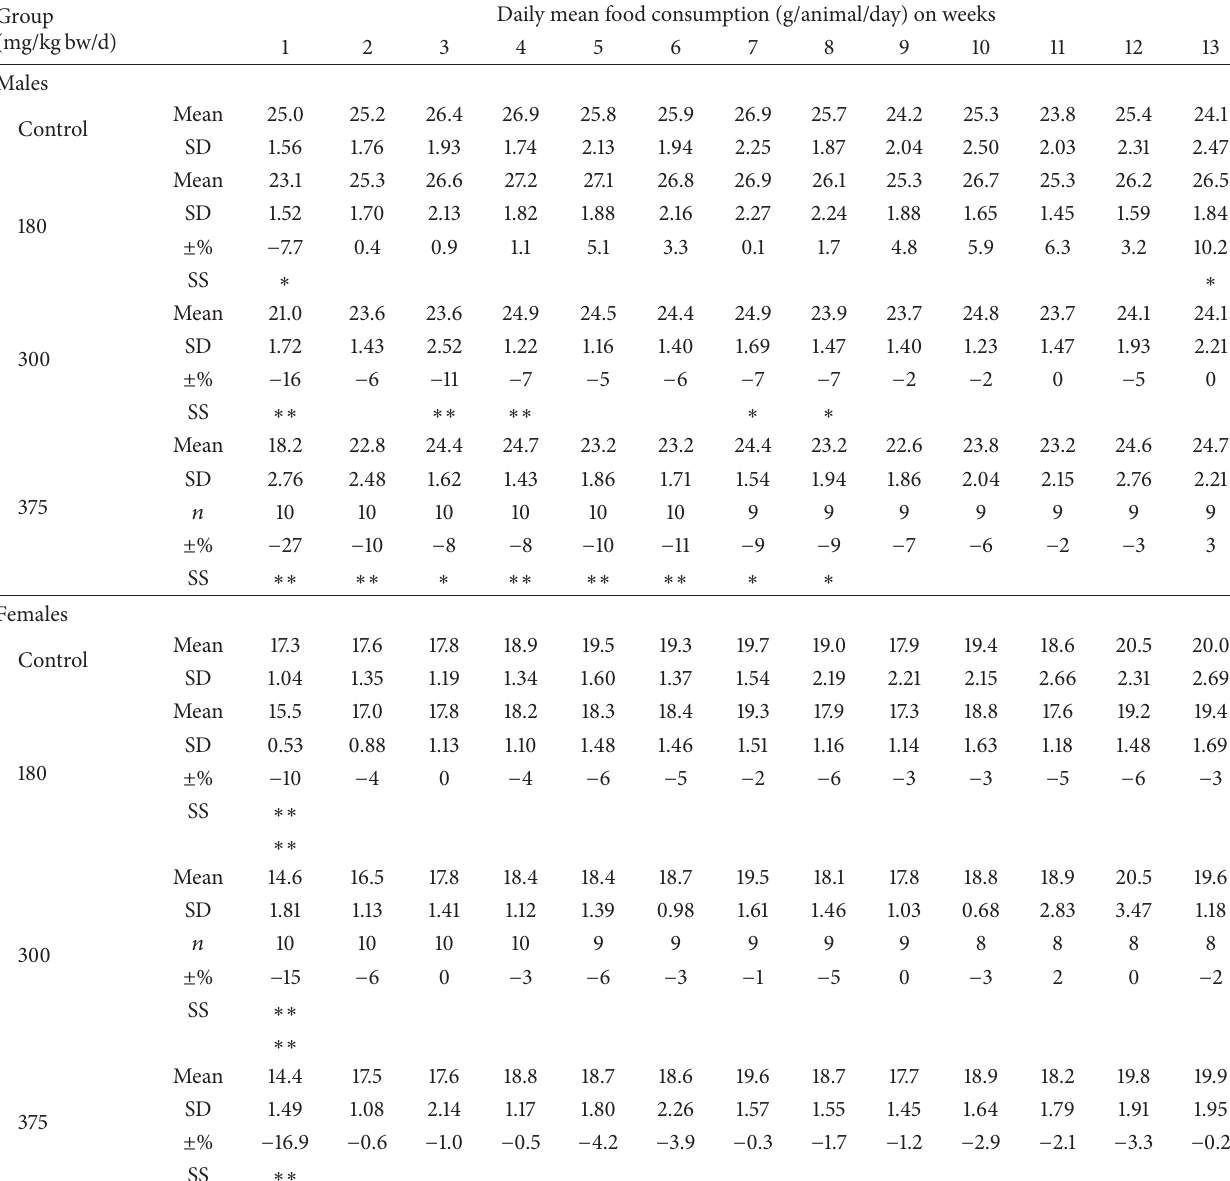
Table 5: Summary of food